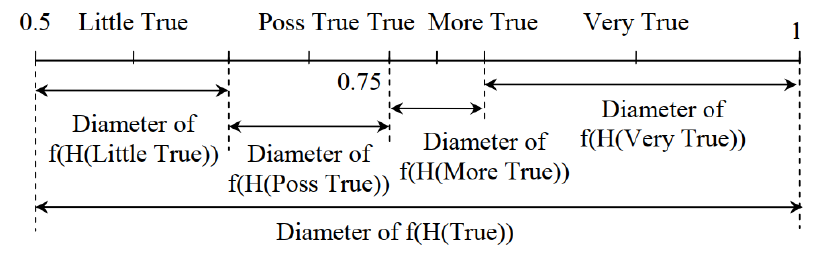
Figure 1. Fuzziness of linguistic values in hedge algebras.